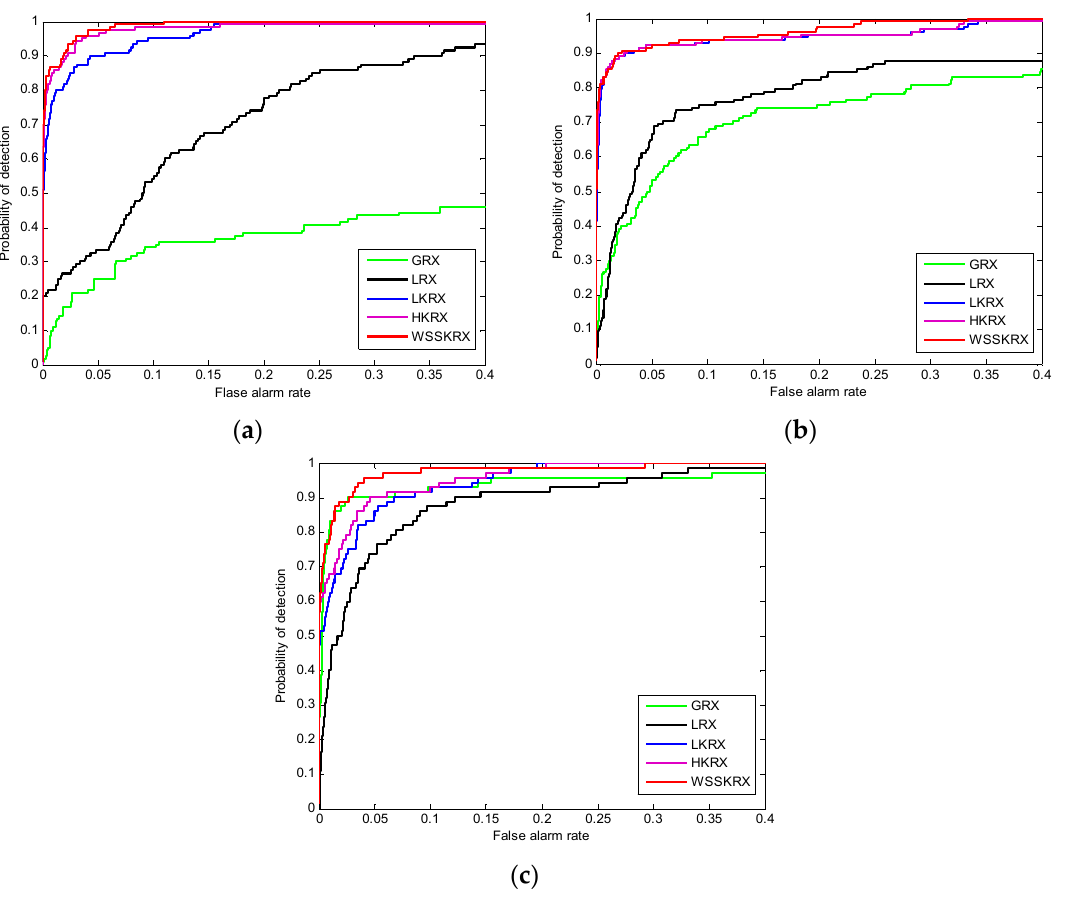
Figure 15. ROC curves of LRX, LKRX and WSSKRX on the two real datasets. ( a ) Synthetic dataset; ( b ) San Diego Airport dataset; ( c ) SpecTIR dataset.